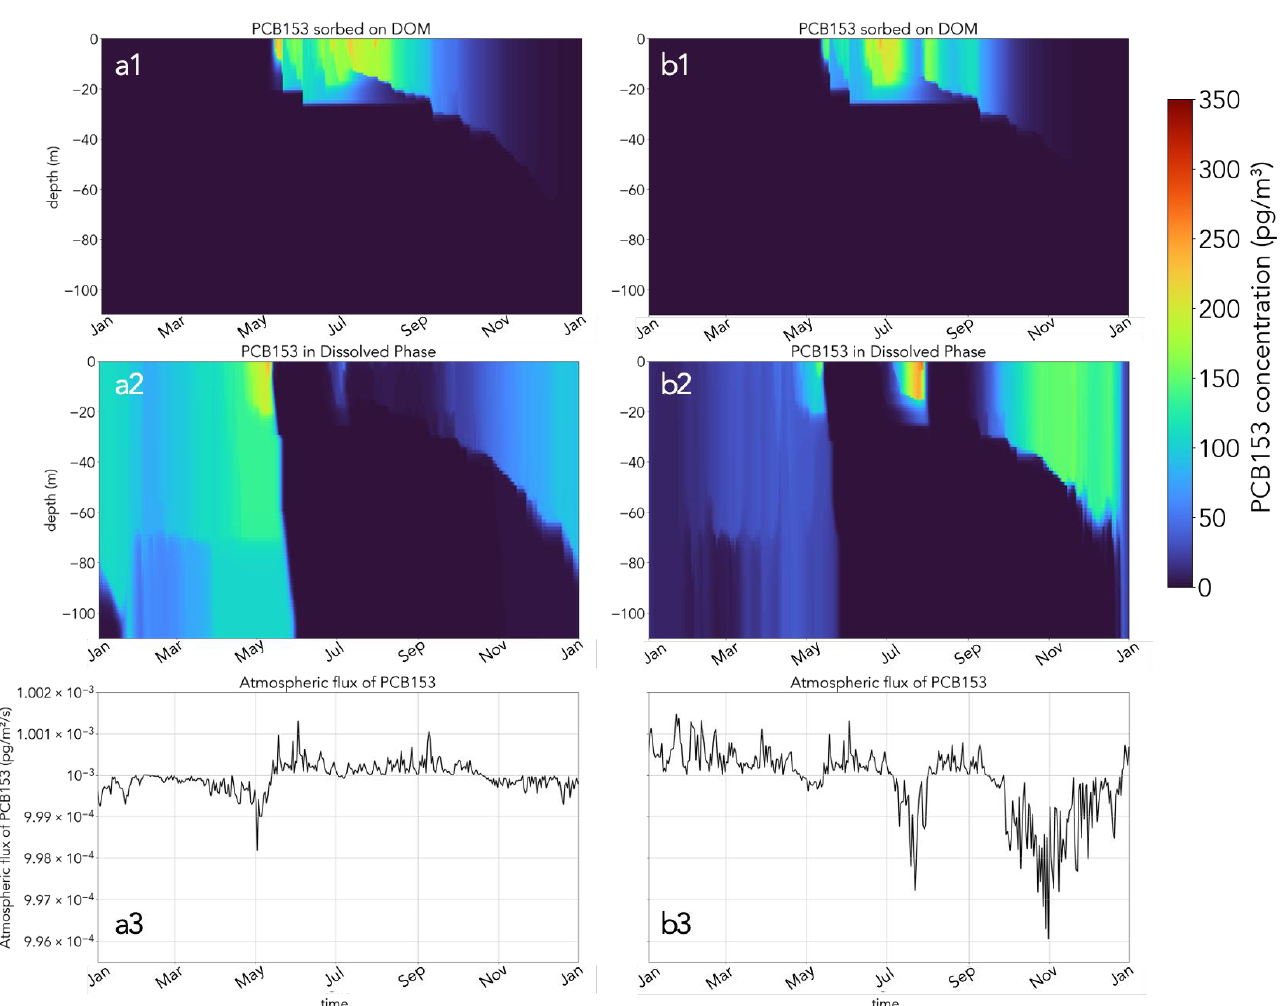
Figure 10. Results of simulations for ( a1 , a2 , a3 ) no-tide scenario, ( b1 , b2 , b3 ) tide scenario (NNS, 2001 year). Concentrations of ( a1 , b1 ) PCB DOM (pg m −3 ); ( a2 , b2 ) freely dissolved PCB 153 (pg m −3 ); ( a3 , b3 ) atmospheric flux of PCB 153 (pg m −2 s −1 ) (direction of flux — from atmosphere to water).